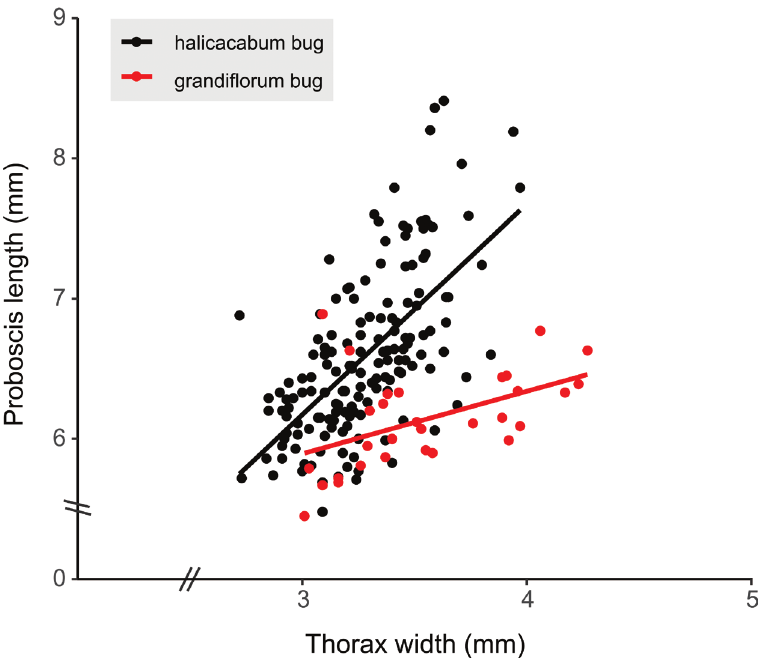
Figure 3. Linear regressions showing the relationship between proboscis length and thorax width for adult Leptocoris mutilatus found in association with Cardiospermum halicacabum and C. grandiflorum . Each point represents an individual.